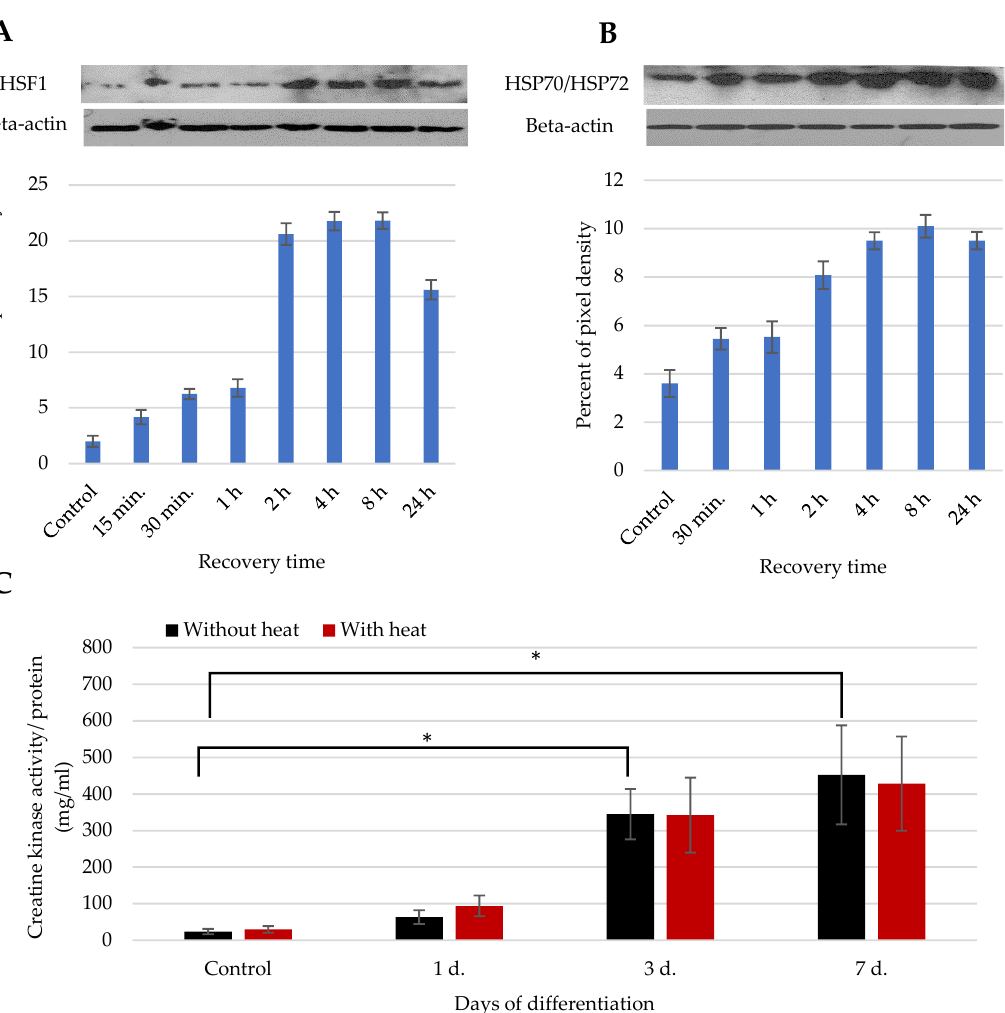
Figure 3. The effect of thermal stimuli on total SM-MSCs population. The level of HSF1 ( A ) (heat shock factor 1) and HSP70/72 ( B ) after the exposure cells to 42 °C heat stimulus for 1 h and different recovery periods (30 min, 1 h, 2 h, 4 h, 8 h, 24 h) under normal growth condition. Representative blots are shown. ( C ) The activity of creatine kinase (CK) in the cells before and after heat stimulus (42 °C for 1 h and 2 h of recovery) for 1, 3 and 7 days in myogenic differentiation medium (2% of FBS in DMEM). Data are shown as mean ± standard deviation (SD) from not less than three repeats ( n = 3) of three cell cultures calculated using the Excel software and are significant at * p ≤ 0.05 level.